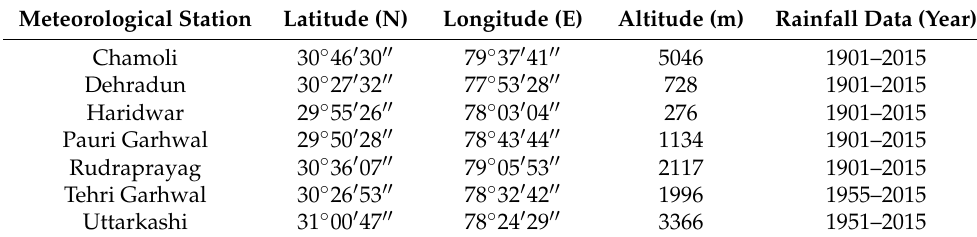
Figure 1. Location map of Garhwal region with seven meteorological stations. Table 1. Details of study stations and rainfall data